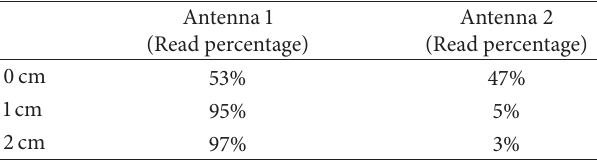
Figure 6: (a) Antenna disposition for horizontal tag transition. (b) Antenna disposition for diagonal tag transition. Table 3: Antenna distance